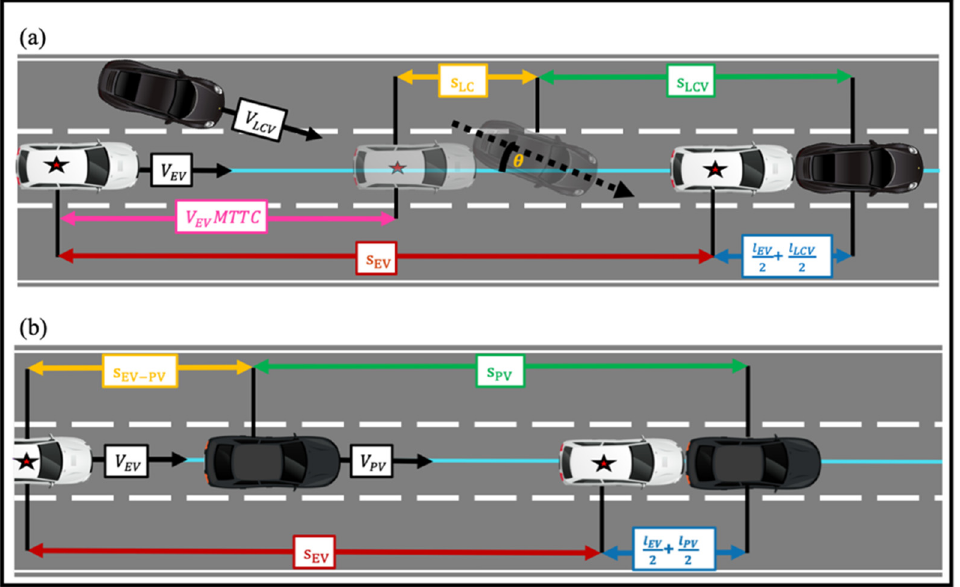
Figure 2. Visual representation of validating ( a ) lane change conflict and ( b ) rear-end conflict.